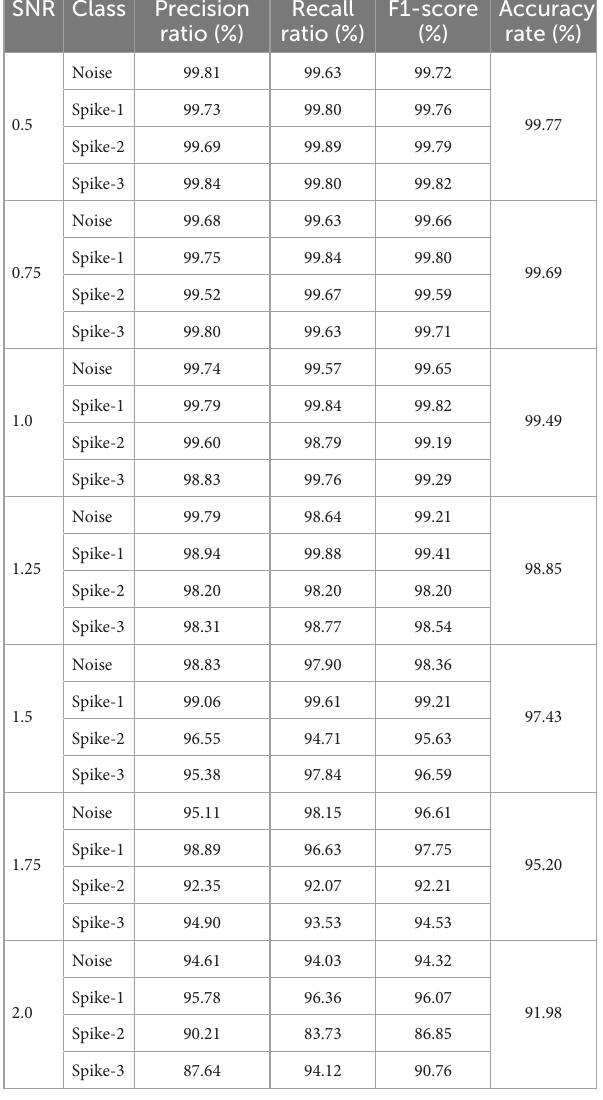
TABLE 6 Performance of proposed approach with 2D CNN for dataset 2 – Precision ratio, recall ratio, F1-score and accuracy rate. Class Precision Recall F1-score Accuracy ratio (%) ratio (%) (%) rate (%) Seizure activity